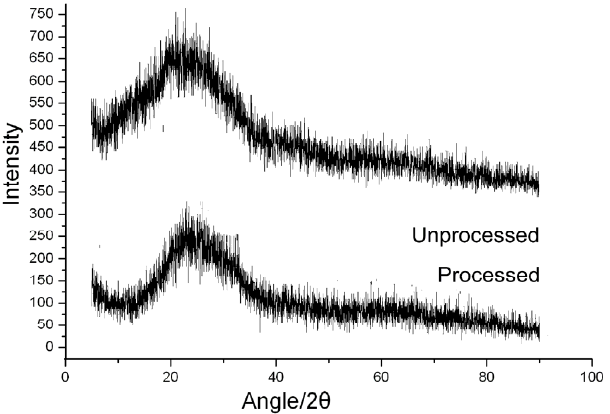
Figure 6. XRD patterns of unprocessed and processed spiramycin (spiramycin microparticles are the micronized spiramycin by homogenate ‐ antisolvent precipitation under optimum conditions).